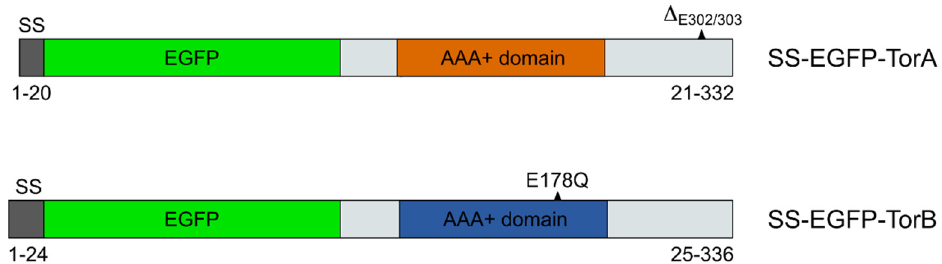
Figure 1. Schematic depiction of expression constructs used in this study. All constructs carried EGFP at the N-terminus. Mutations resulting in loss-of-function in TorA and B are indicated. Numbers given below represent the corresponding amino acid residues of the Torsins in the constructs used. SS: signal sequence.